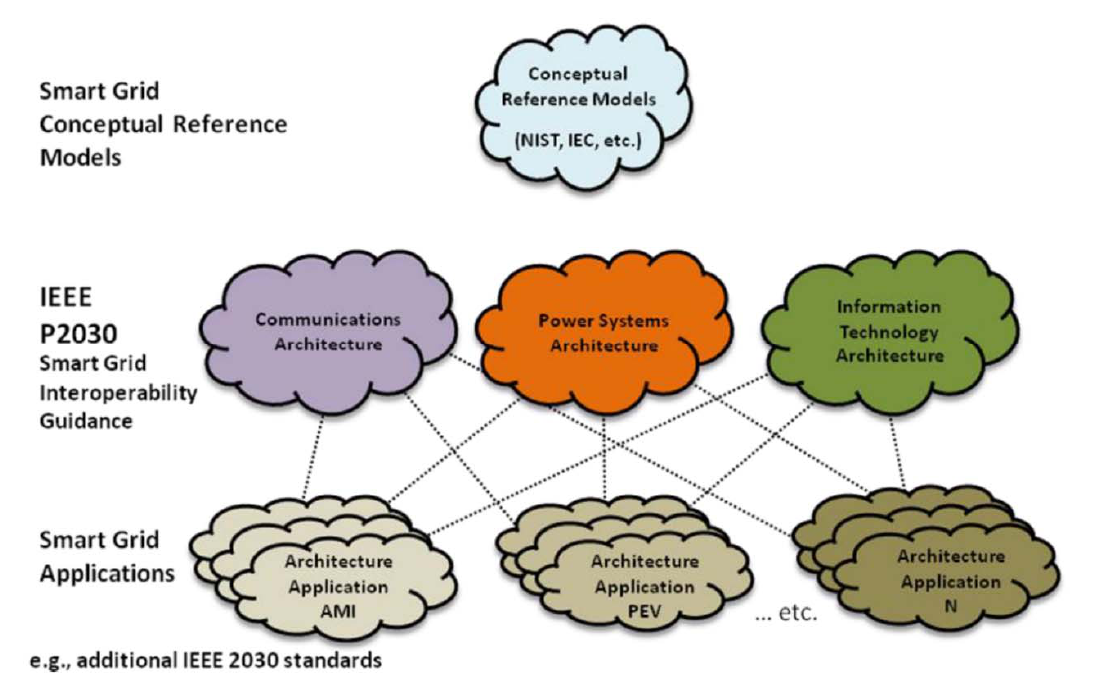
Figure 2. Evolution and scope of IEEE 2030 standardization process